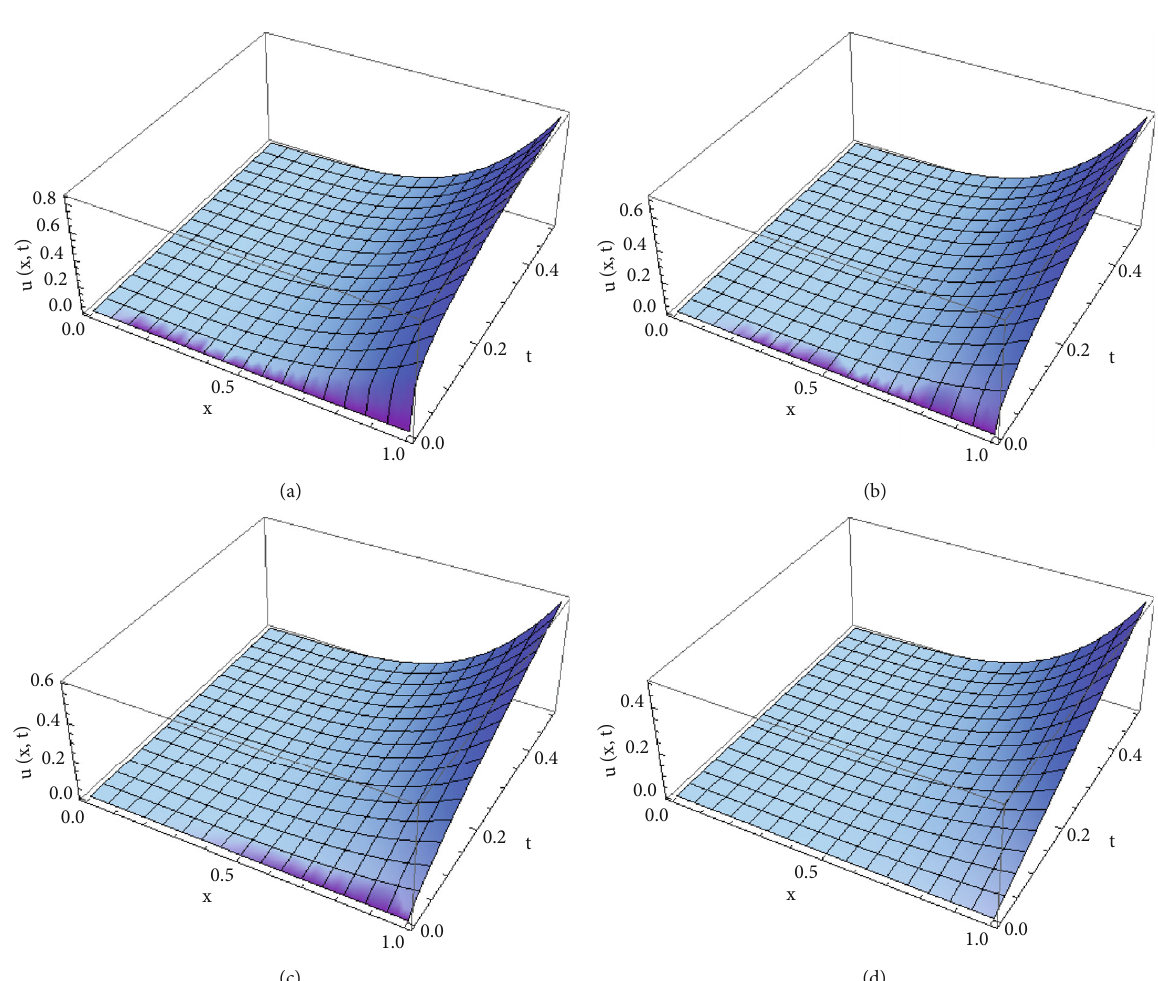
Figure 5: The physical behavior of FRDTM solution of Eq. (37) for (a) α = 0 : 25 , (b) α = 0 : 5 , (c) α = 0 : 75 , and (d) α = 1